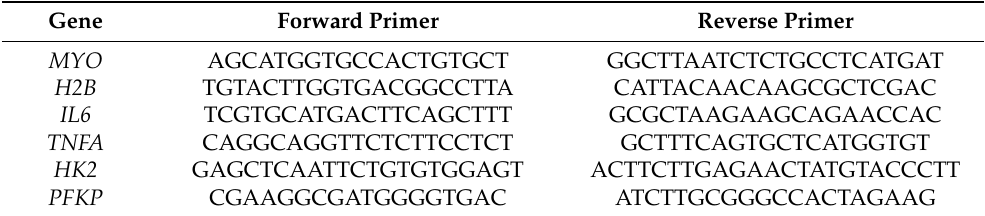
Table 2. Primer sequences used for